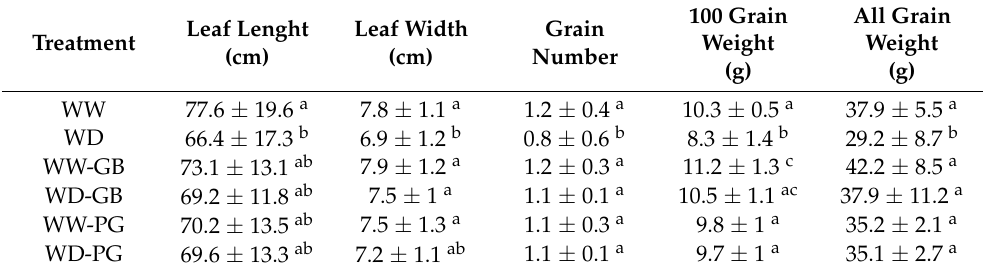
Table 2. Growth and yield parameters in greenhouse experiment.